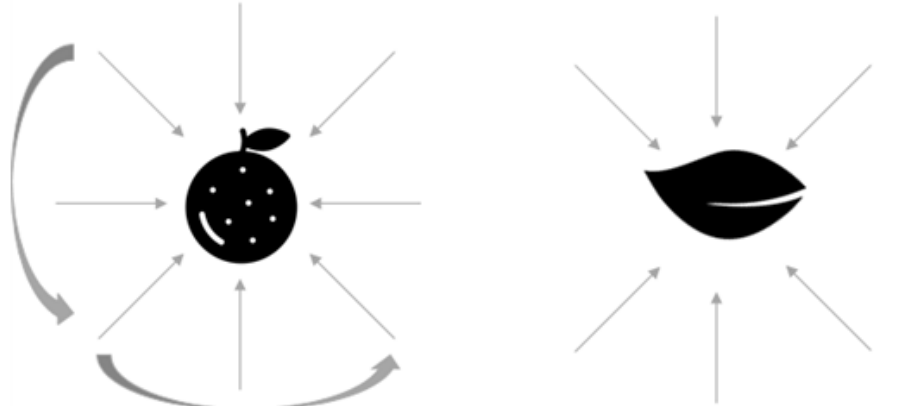
Figure 2. Dataset shooting